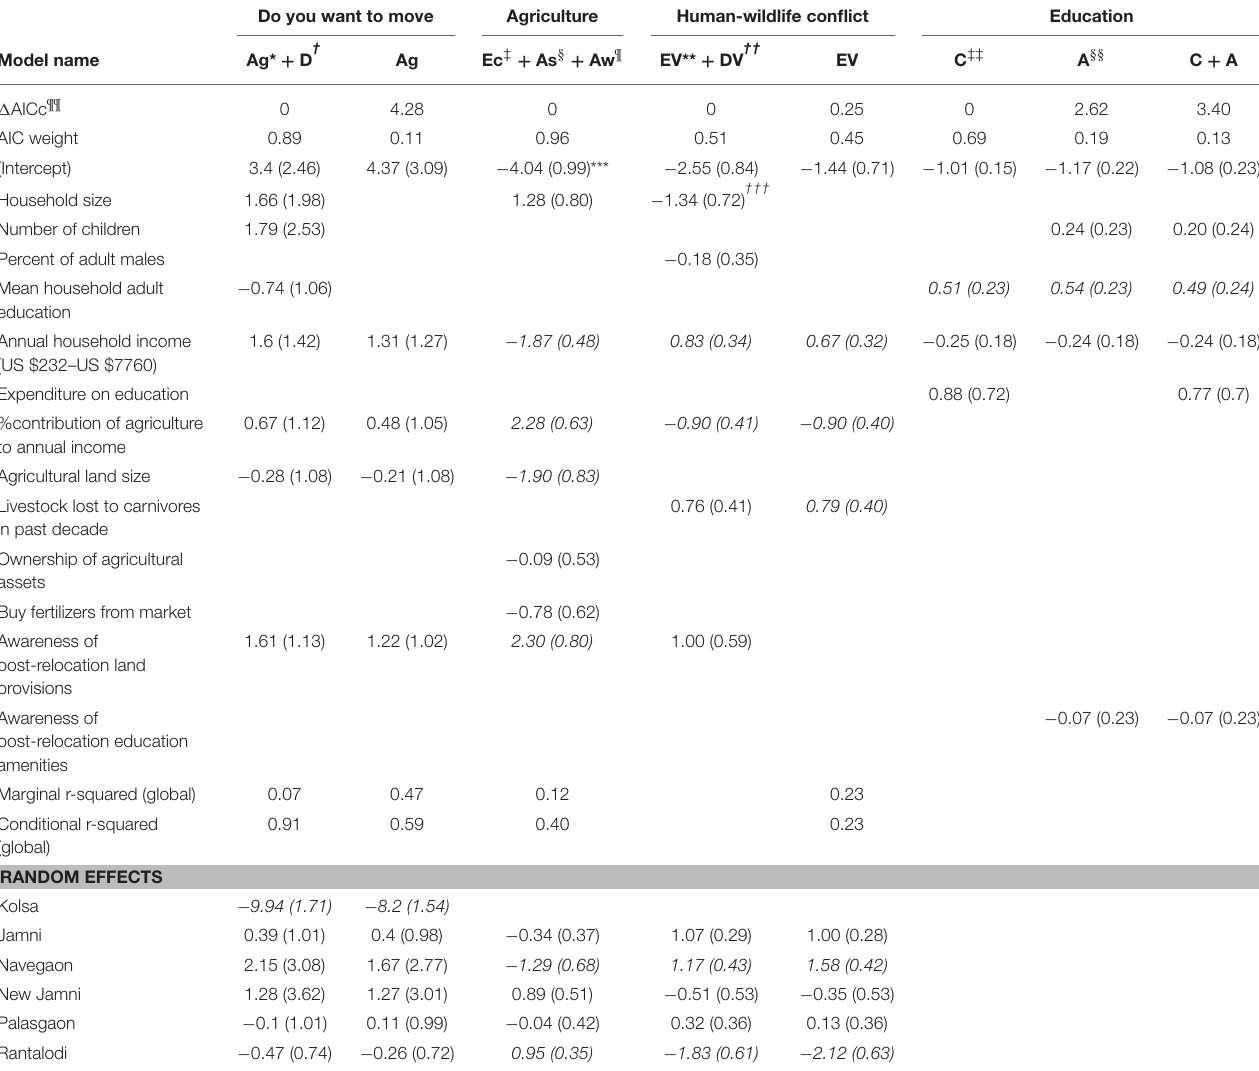
TABLE 1 | Top-ranked models (cumulative weight > 0.95) and beta estimates of fixed, and random effects for predicting the likelihood that households want to relocate, and top-ranked reasons for relocation i.e., better agricultural opportunities, to minimize losses to human-wildlife conflict, and for improved education facilities at Tadoba-Andhari Tiger